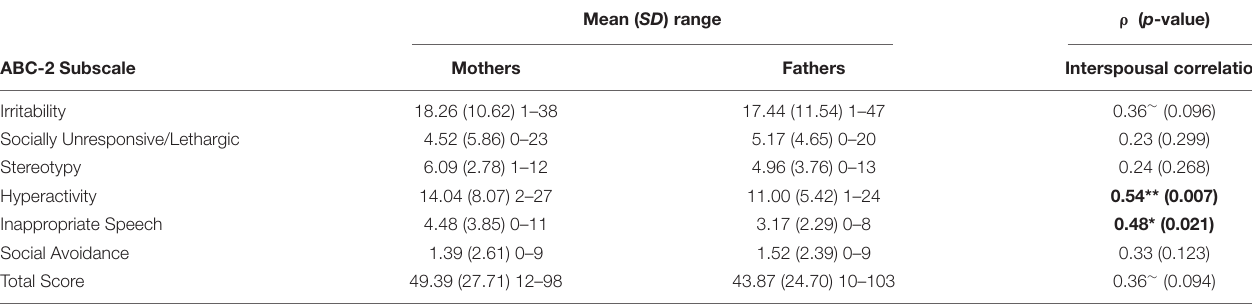
TABLE 8 | Mother-father comparisons of SRS-2 subscale T-scores ( n = 46).